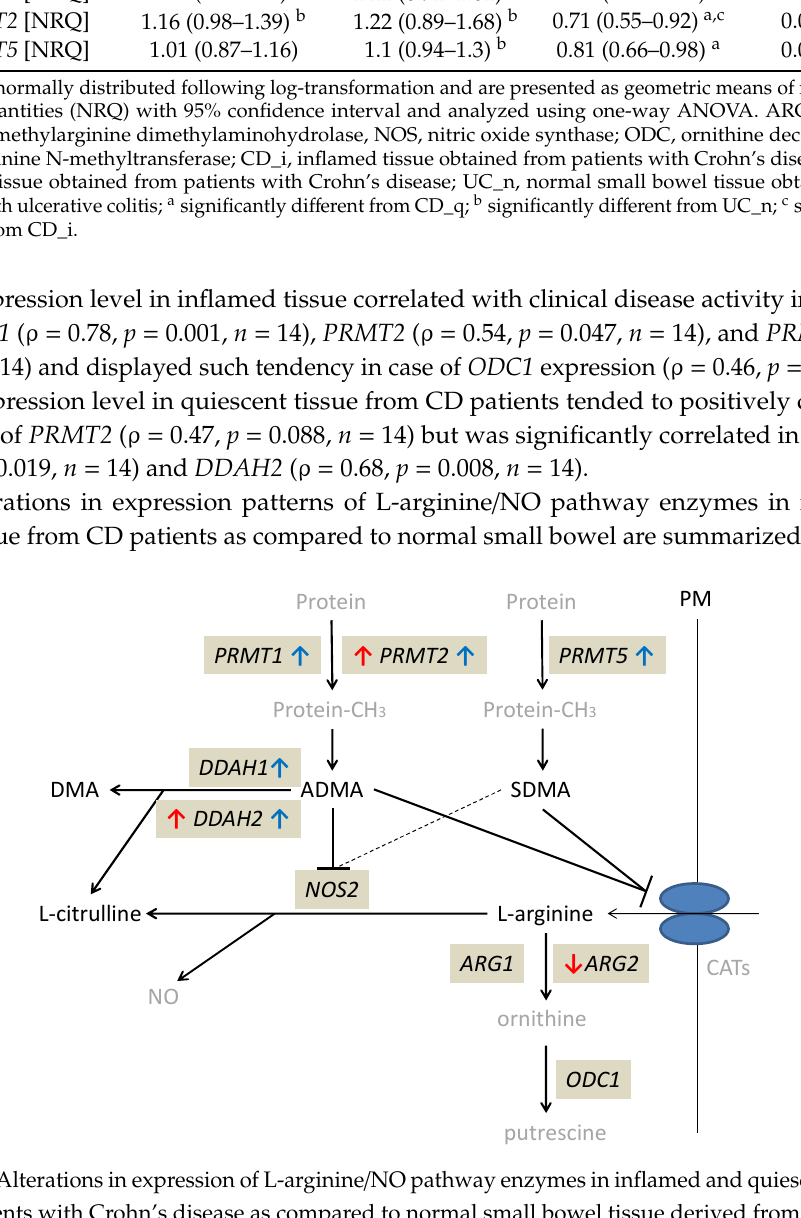
Table 4. L-arginine/NO pathway-associated enzymes in inflamed and quiescent small bowel.